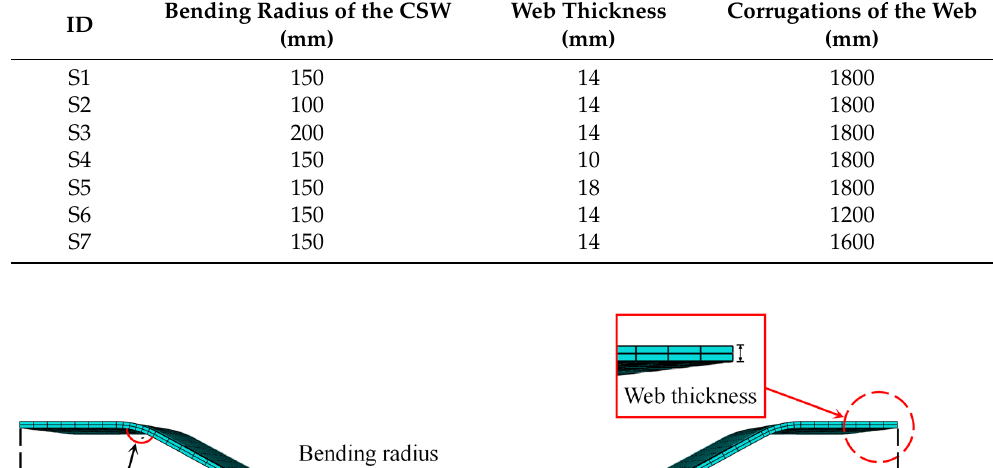
Figure 15. Comparisons of numerical and experimental results: ( a ) load-deflection curves; ( b ) stress at CW2 and CW5.